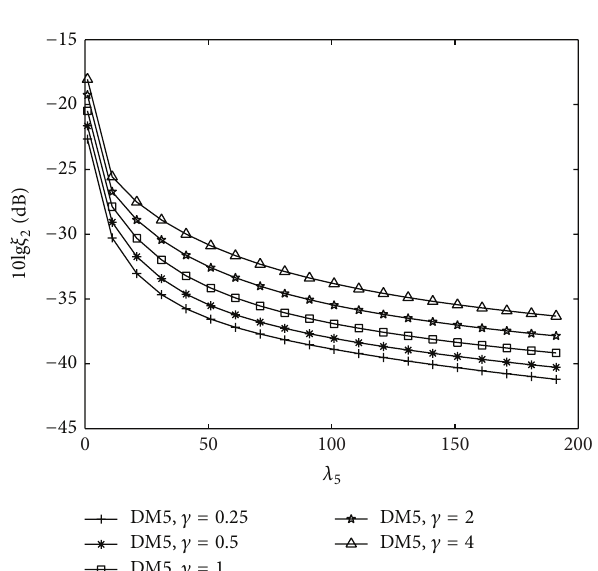
𝜉 2 , where the spatial matrix filters were